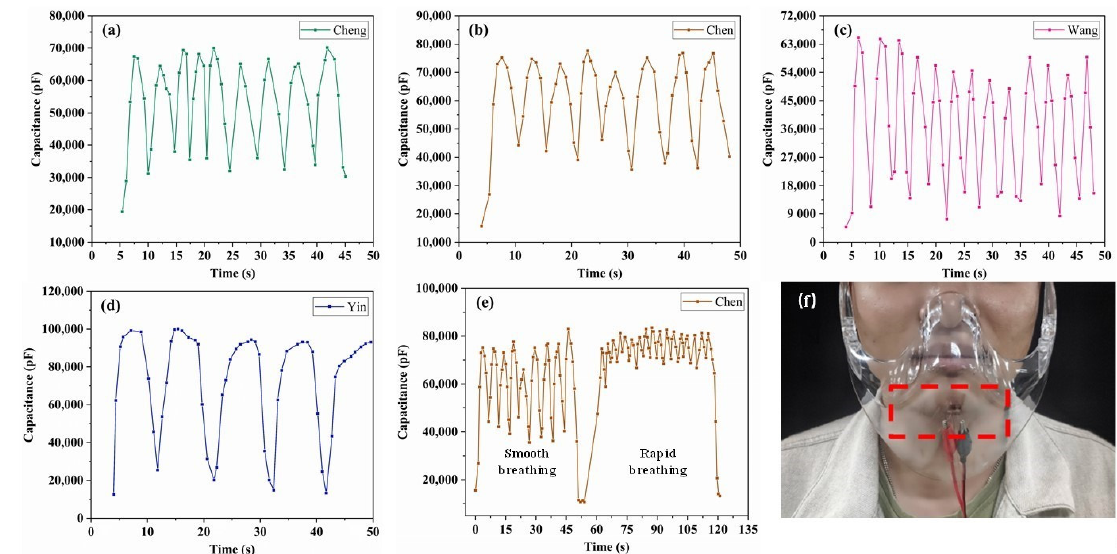
Figure 11. Response curve of human breathing monitoring. ( a – d ) Smooth breathing of different adults and ( e ) different breathing states of an adult. ( f ) Sketch map of human breathing